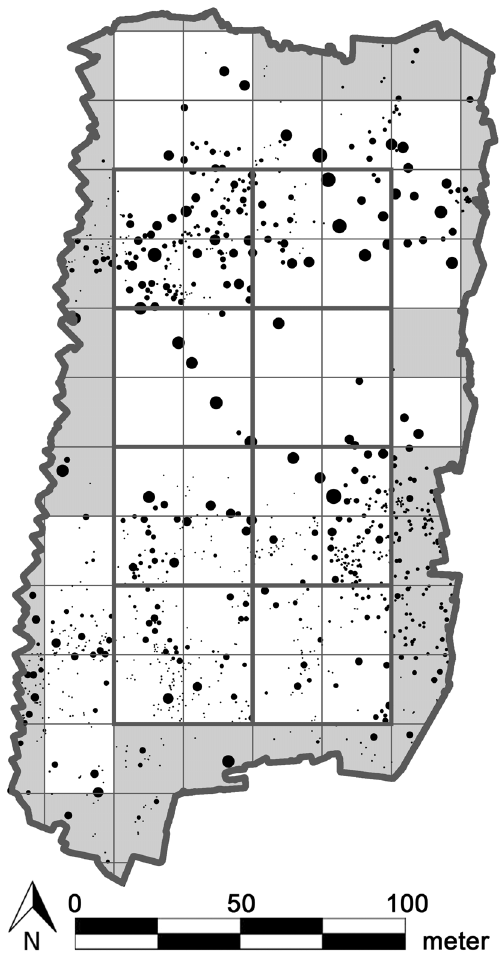
Figure 2. Study area with R.stricta patches displayed as discs. To make all unbranched individuals visible in this figure, they were enlarged to discs of 0.25 m diameter, regardless of their actual size. The surface area of the other vegetation patches (i.e. all branched individuals) are displayed proportional to their actual surface area. A grid with square plots with sides five times the diameter of the largest observed nebkha (5 6 4.2 m=21 m) is overlain over the site. Only cells with white background completely fall inside the study site. Gray plots were omitted from the calculations. A second grid with cell sides ten times the diameter of the largest observed nebkha (10 6 4.2 m=42 m) is also overlain. The sides of these grid cells (8 in total) are depicted in